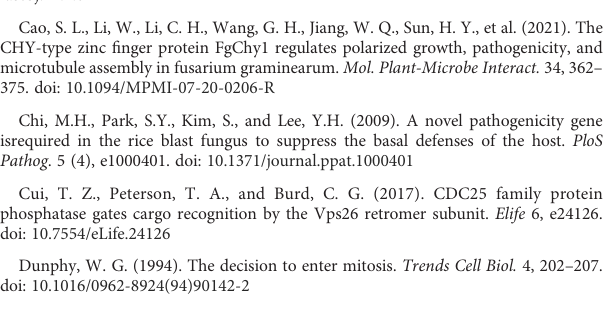
SUPPLEMENTARY FIGURE 6 MoMih1 is required for the hydrophobicity of M. oryzae . (A) . Hydrophobicity assay for the MoMih1 mutants. Drops of water were inoculated on the colony surfaces of the tested strains. An easily-wettable phenotype of MoMih1 mutants was observed and photographed at 24 hpi. (B) . The transcriptional levelsof hydrophobingenes. Theexpression offourhydrophobingenes, such as MGG_09134, MGG_10105, MoMPG1 , and MoMHP1 , was signi fi cantly reduced in the MoMih1 mutant. “ ** ” mean signi fi cant difference in gene expression ( p < 0.01), and error bars represent